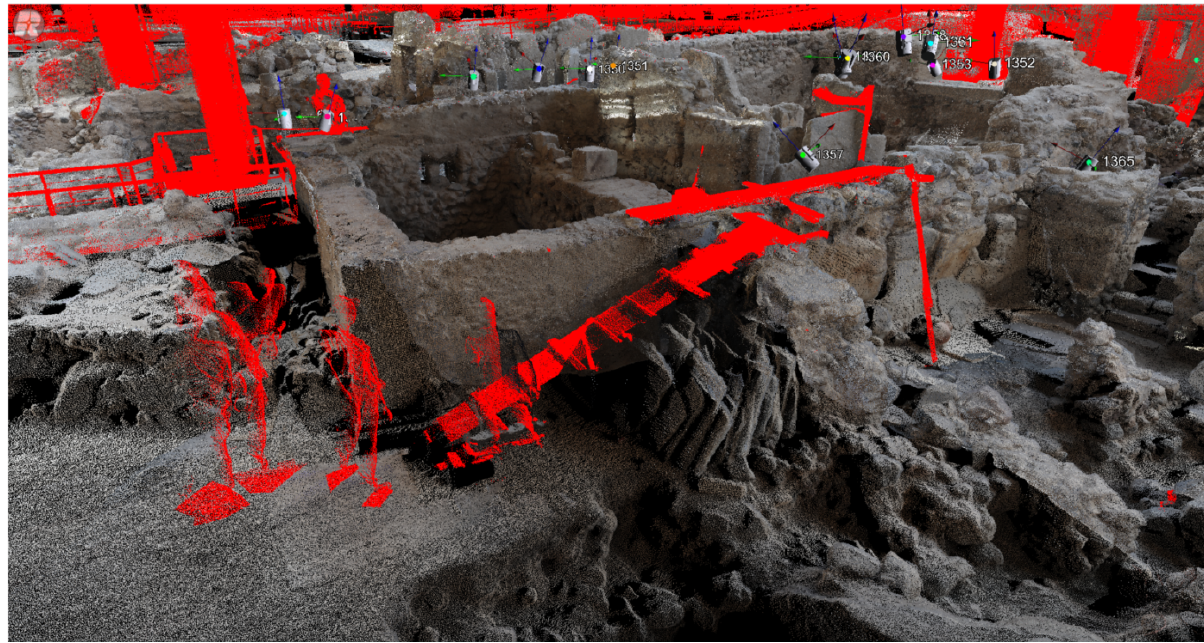
Figure 7: Laser scanning point cloud with Room 2 of Complex Beta in the centre and the modern structures separated (red). A virtually removed modern wooden ramp used by the architects studying the building can be seen in foreground.